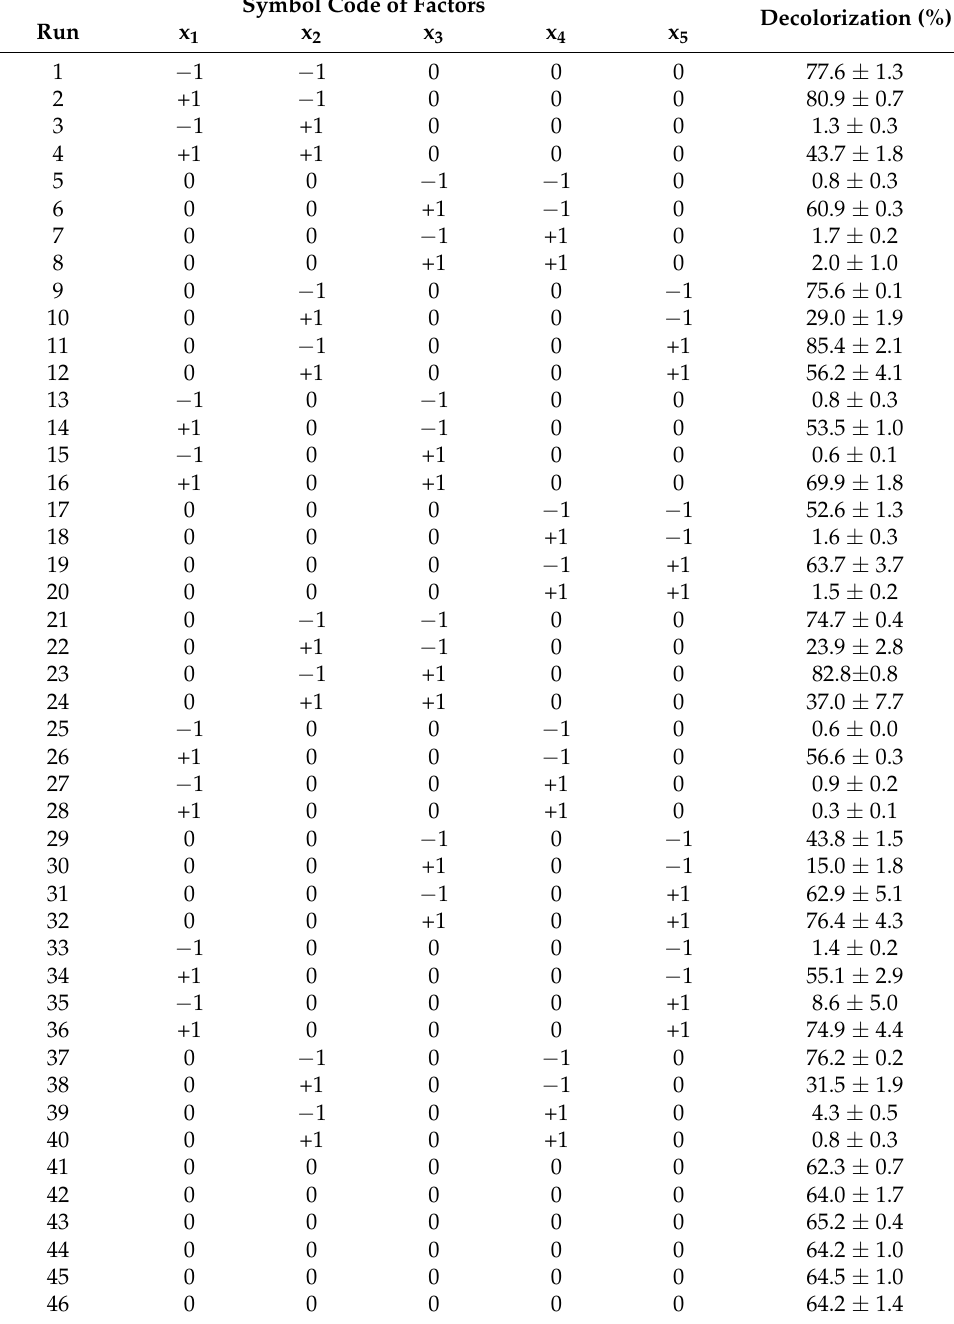
Table 4. The Box–Behnken design and data on percent decolorization at 120